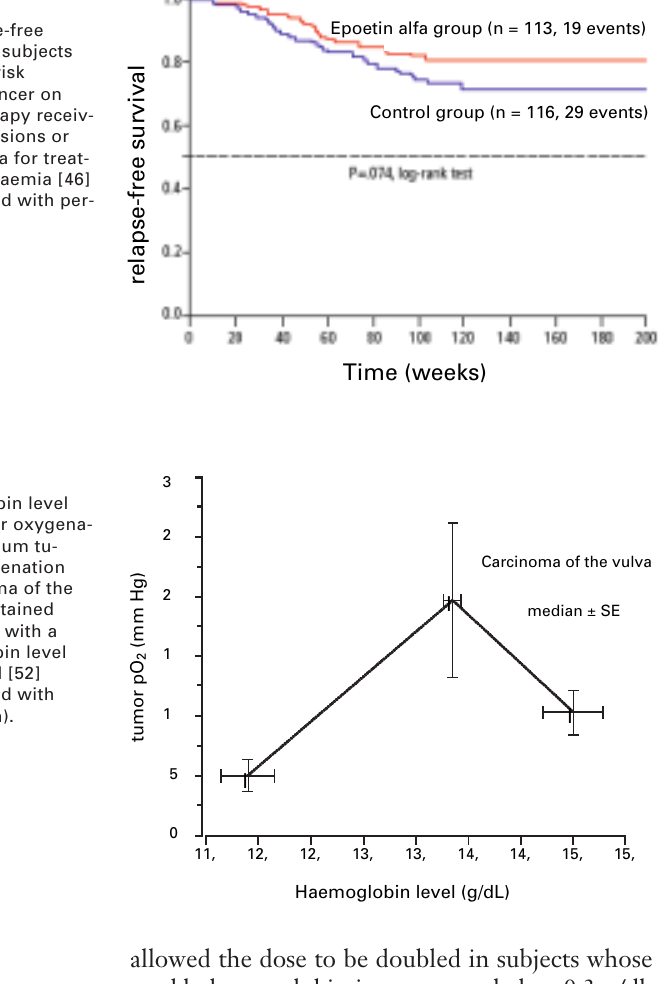
Recurrence-free survival in subjects with high-risk cervical cancer on chemotherapy receiv- ing transfusions or epoetin alfa for treat- ment of anaemia [46] (reproduced with per- mission).